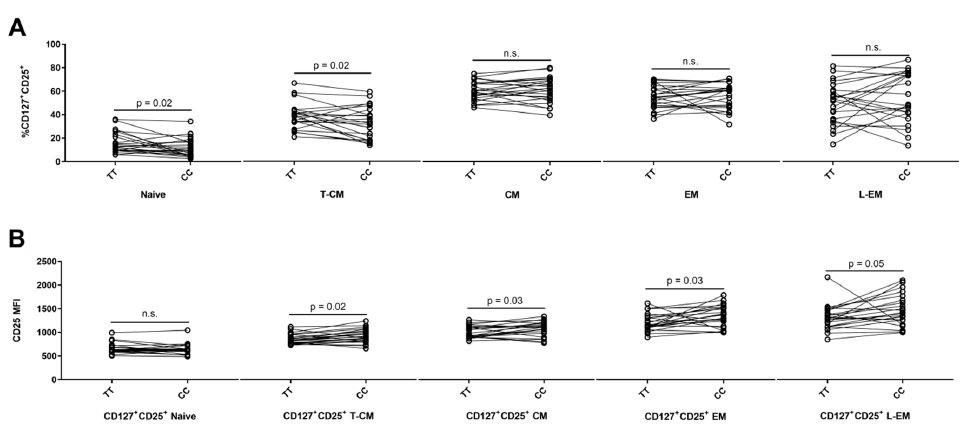
Figure 2. IL2RA genotype associations on di ff erentiation of CD4 + T cells. Homozygous carriers of both MS-associated IL2RA SNPs, rs2104286 and rs11256593, are defined by TT for the risk genotype (N = 23) and CC for the protective genotype (N = 23). Gating strategy is outlined in Figure 1A–E. ( A ) Di ff erences between TT carriers and CC carriers on frequency of CD127 + CD25 + naïve (Paired t test, mean of di ff erence = − 4.6; 95% CI = − 8.5 to − 0.7), T-CM (Paired t test, mean of di ff erence = − 5.6; 95%